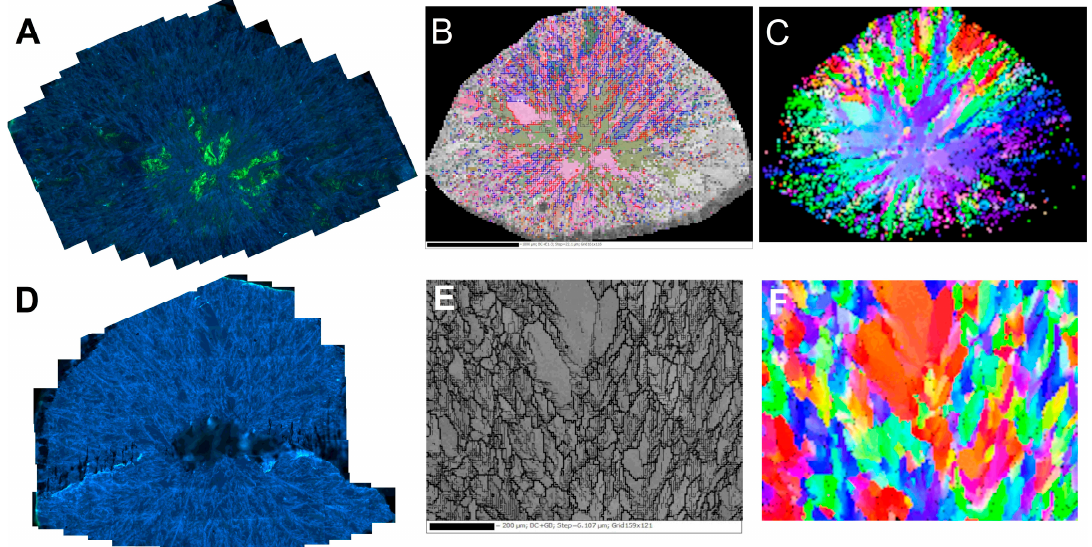
Figure 6. Cathodoluminescence ( A , D ) and EBSD maps. Top row—“large” specimen, bottom row—“small” one. ( B , E )—grain and sub-grain (thin lines) boundaries of the studied domains. In B, the SEM image is superimposed on the Euler angles map of the grains’ misorientation. ( C , F )—orientation of the grains color-coded as Euler angles. The low quality of the sample edges of the images ( B , C ) is due to the technical limits of the movement range of the sample holder.